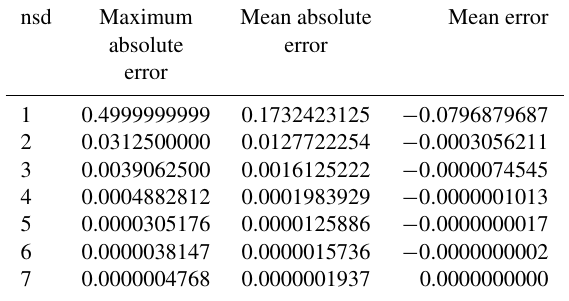
Table 3. Maximum absolute errors, mean absolute errors and mean errors of the Digit Rounding algorithm preserving a varying num- ber of significant digits (nsd) on an artificial dataset composed of 1000000 values evenly spaced over the interval [ 1 . 0 , 2 . 0 ) . The er- ror metrics are defined in Sect. 4.